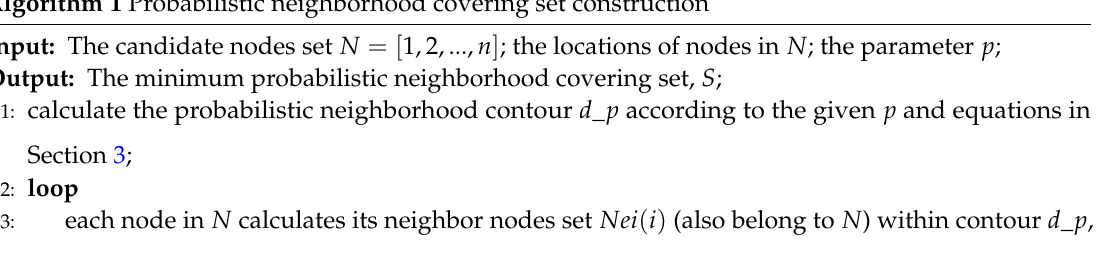
Algorithm 1 Probabilistic neighborhood covering set construction